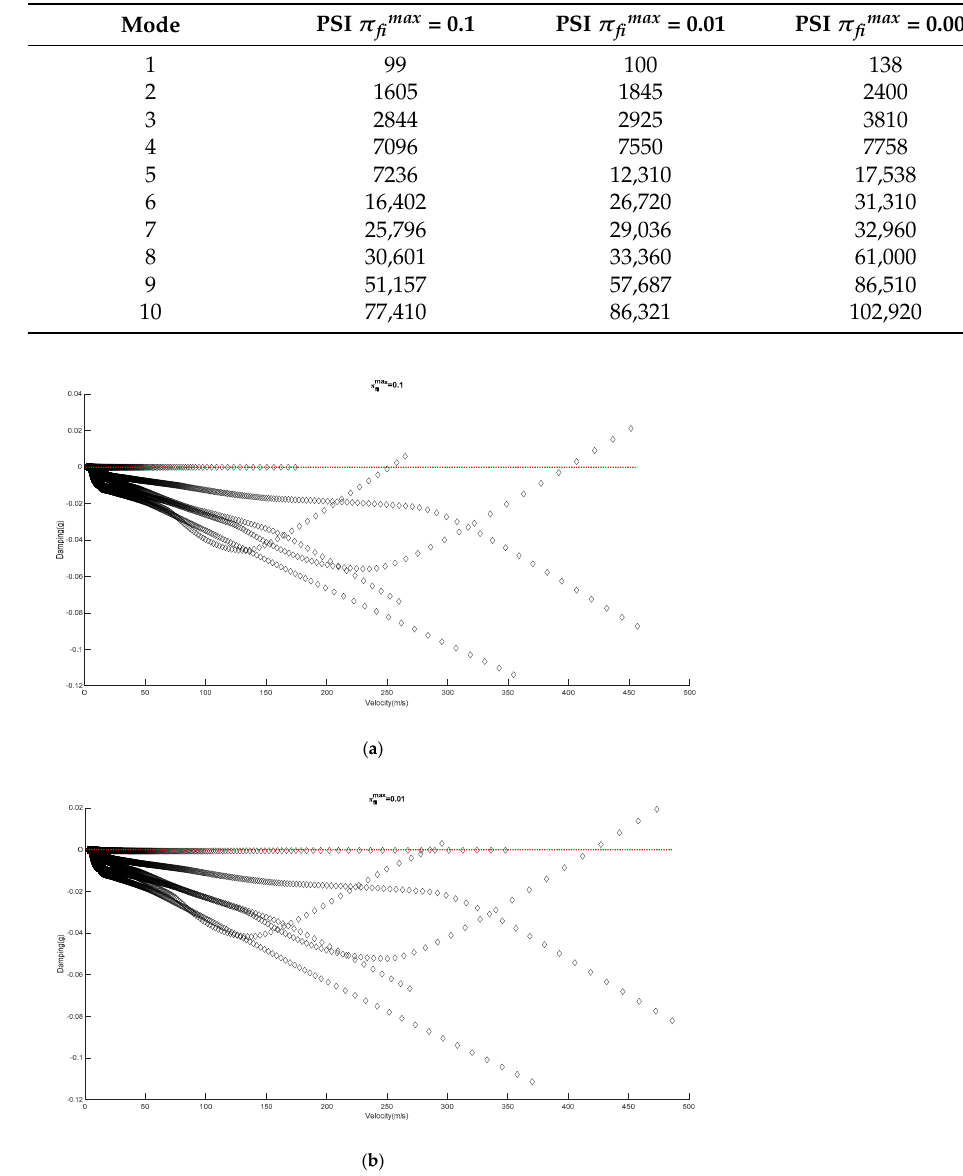
Table 4. The PSI π fimax various on natural frequency of the wing (Hz).